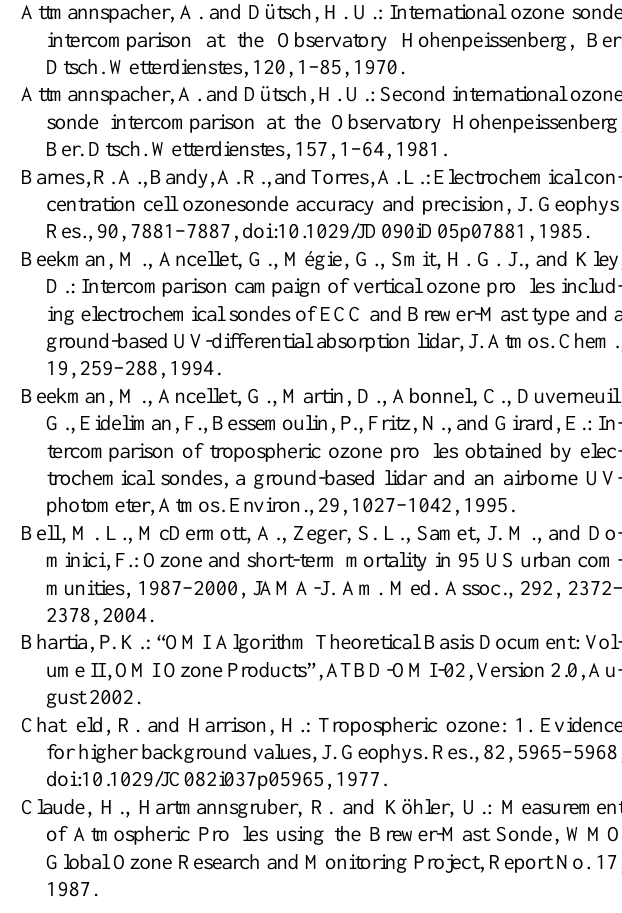
Fig. 10. Decadal average tropospheric ozone as a function of al- titude, compared to the most recent decade. Averages are over all 5 ◦ × 5 ◦ pixels on the global map for which there is data for all four decades. Also shown for reference are a quadratic best fit to BM response data from Tarasick et al. (2002), the average difference between BM and ECC response from ozonesonde intercomparisons in 1970 and 1978 (Attmannspacher and Dütsch, 1970, 1981), and the average response of BM sondes with respect to a reference UV photometer on the same balloon in 1983 (Hilsenrath et al.,